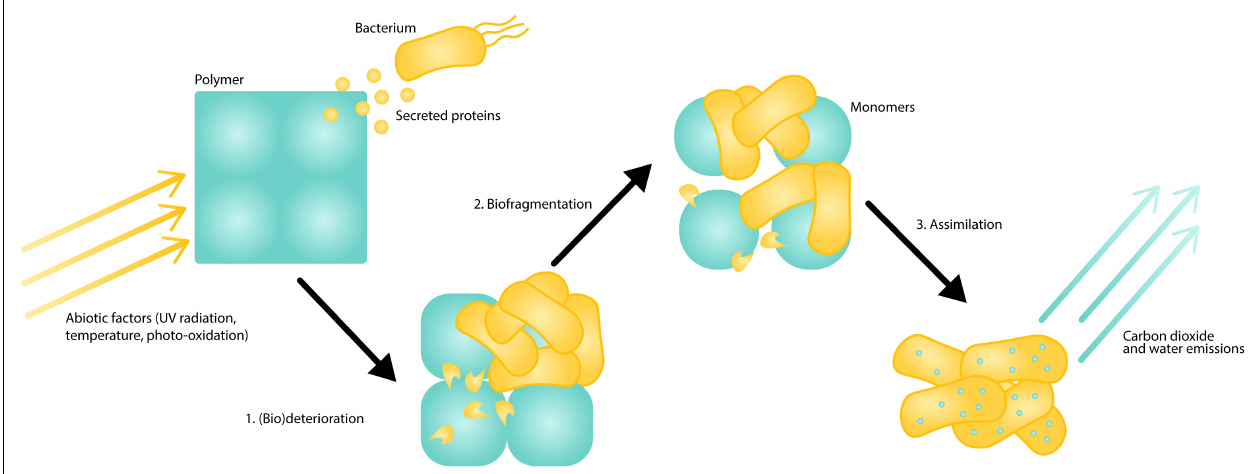
FIGURE 1 | Schematic illustration of plastic biodegradation as a complex, step-wise pathway. First, during biodeterioration (1), abiotic and biotic factors, like light and secreted hydrophobins, modify the polymer surface and increase its surface area. Next, during biofragmentation (2), organisms secrete enzymes that break the polymer down into its monomer components. Finally, during assimilation (3), the organism metabolizes the monomers into biomass, carbon dioxide, and